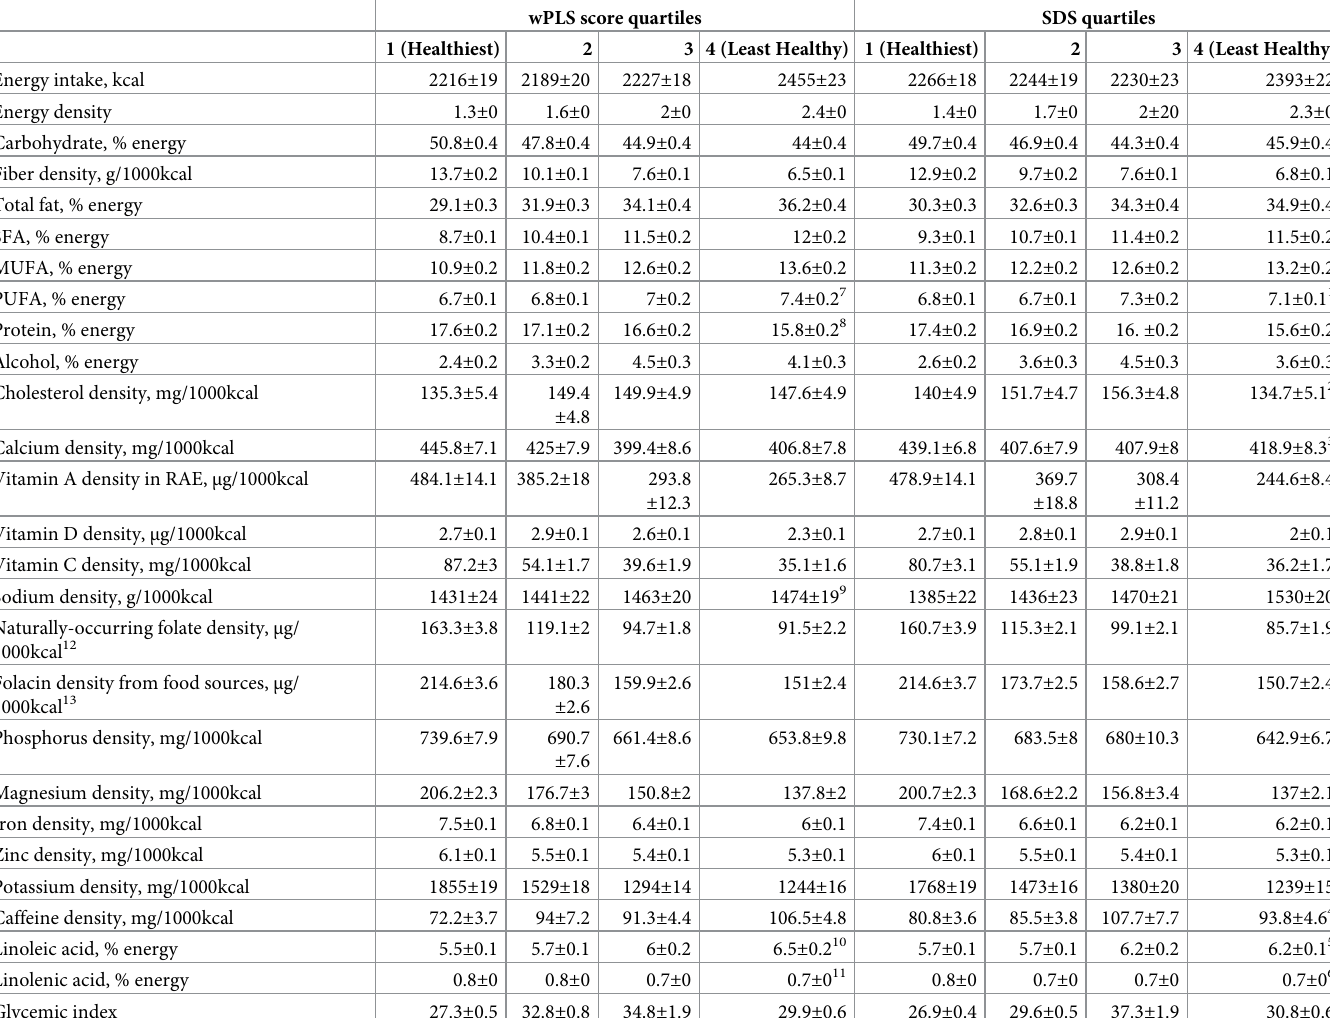
Table 5. Weighted mean daily intake of macro- and micronutrients across quartile categories of energy-dense, high-fat and low-fiber density (“obesogenic”) dietary pattern score generated from wPLS, and the simplified dietary pattern score (SDS) among Canadian adults from CCHS-Nutrition 2015 ( n = 12,049). wPLS score